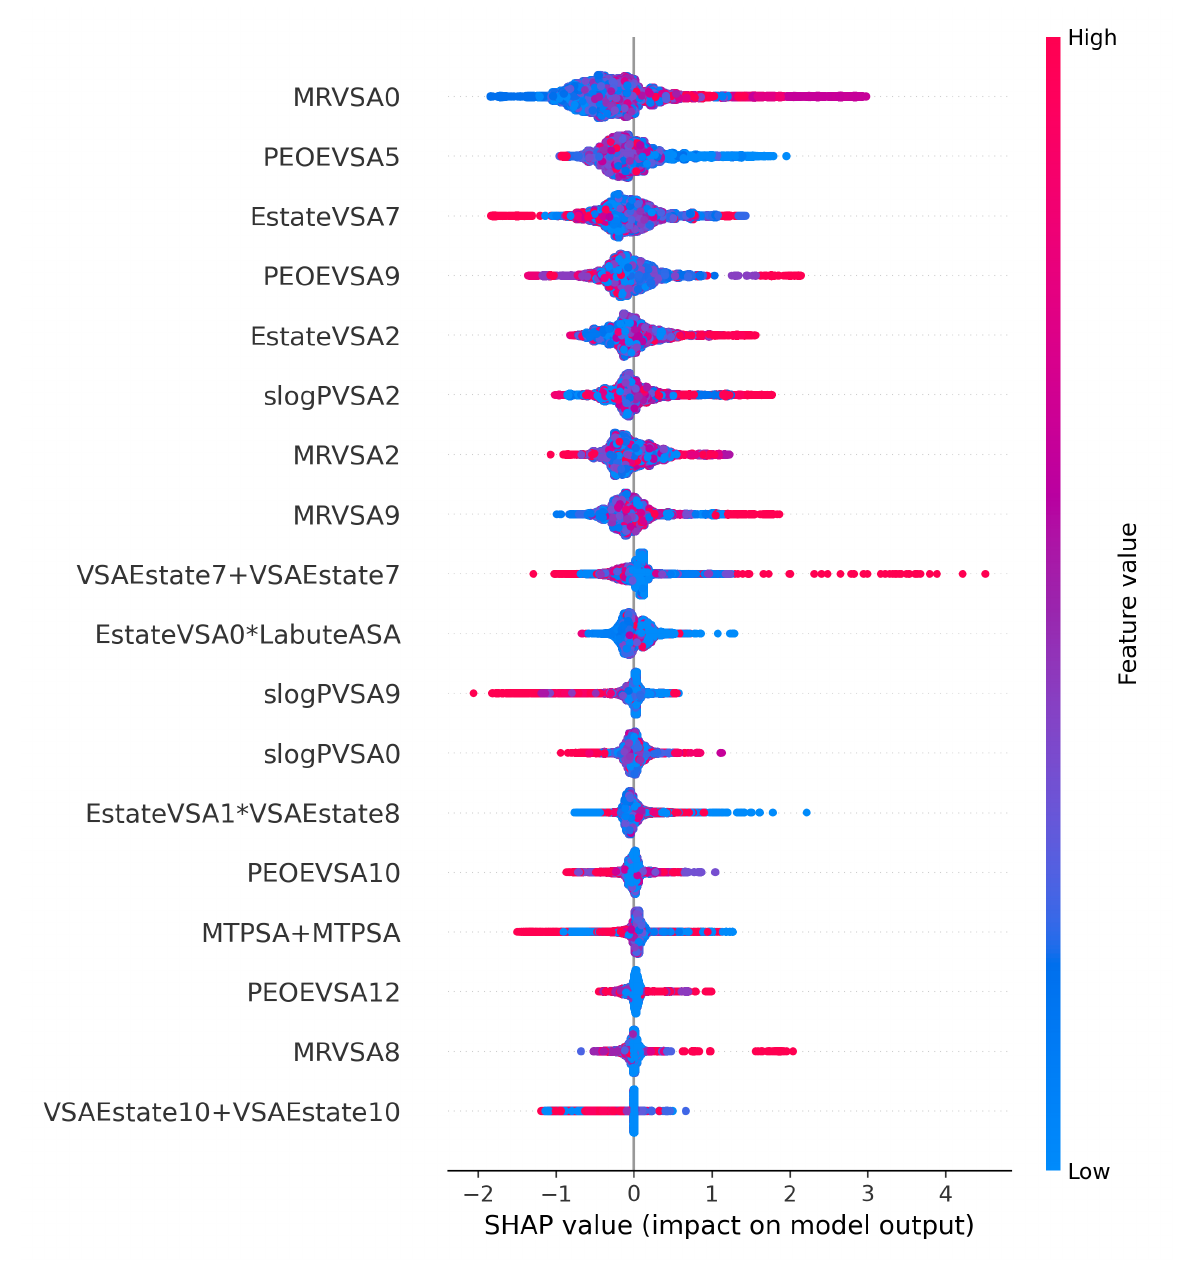
Figure 3. The SHAP (SHapley Additive exPlanations) plot of eighteen optimal features. The red dots of MRVSA0, EstateVSA2, MRVSA9, MRVSA8 and blue dots of PEOEVSA5, MTPSA+MTPSA, VSAEstate10+VSAEstate10 gather on the right side of the x-axis, indicating that the high values and low values of these features, respectively, direct the model in recognizing the non-significant DFIs. High PEOEVSA5, EstateVSA7, slogPVSA9, MTPSA+MTPSA , and low values of MRVSA0, MRVSA9 help detect the negative DFIs. The positive DFIs are identified by the increasing values of PEO- EVSA5, EstateVSA0*LabuteASA, EstateVSA1*VSAEstate8 and the decline of PEOEVSA9, EstateVSA7, EstateVSA2, slogPVSA9, MRVSA2, VSAEstate7+VSAEstate7, slogPVSA0, PEOEVSA12